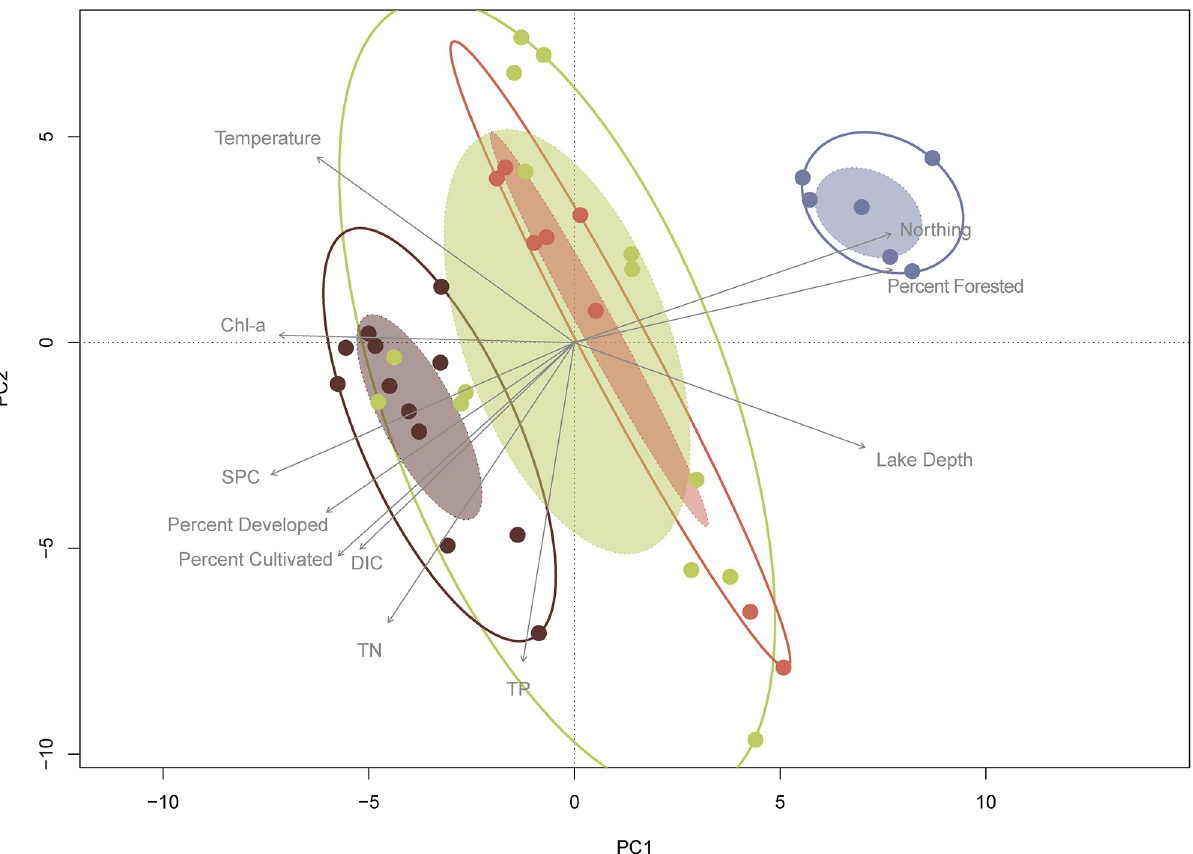
Fig 3. Beta-diversity: Principal component analysis of samples. Principal component analysis (PCA) of surface sediment microbiome samples where color represents ecological region. Components one and two explained 31.4% of the total variance. Environmental variables were fit using linear regressions where each component was plotted as a function of an environmental vector and those with p < 0.01 were plotted. Solid line ellipses are the outer sample bounds for each region and the shaded ellipses are the standard error of the weighted centroids for the data. Abbreviations: Dissolved Inorganic Carbon (DIC), Total Nitrogen (TN), Total Phosphorus (TP), Chlorophyll-a (Chl-a), Specific Conductance (SPC).